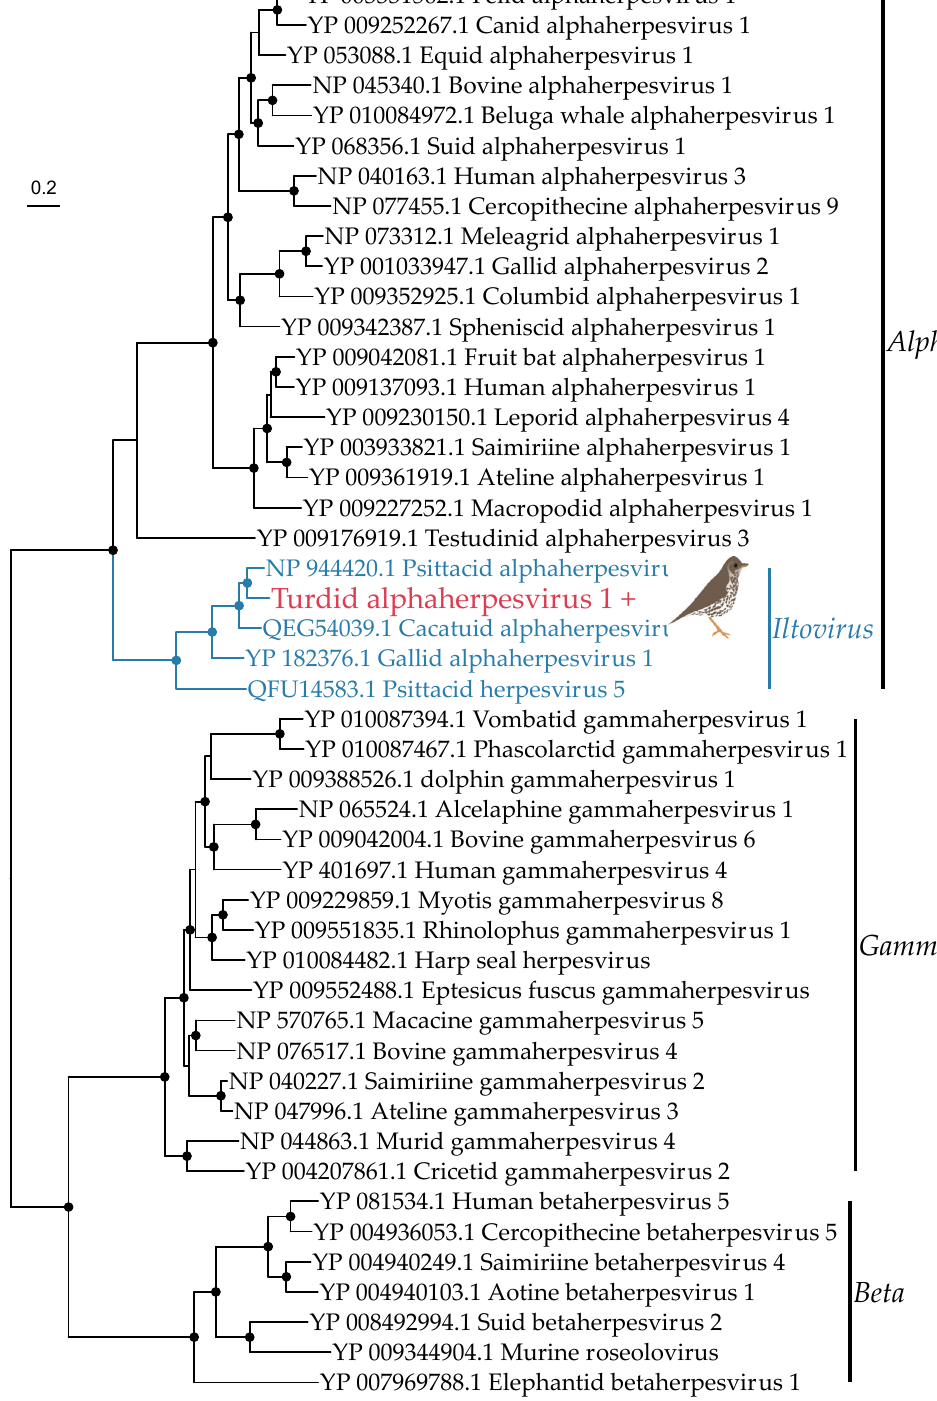
Figure 6. Phylogeny of the Herpesviridae based on the capsid gene (alignment length of 1279 amino acids). The alpha -, beta - and gammaherpesvirinae subfamilies are shown in black. Colours and symbols as per Figure 5.